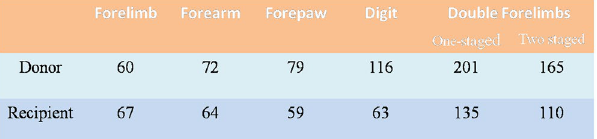
Figure 1. Average operation time (min) for harvesting amputated limbs in donors and implanting them in recipients in different types of temporary ectopic implantation